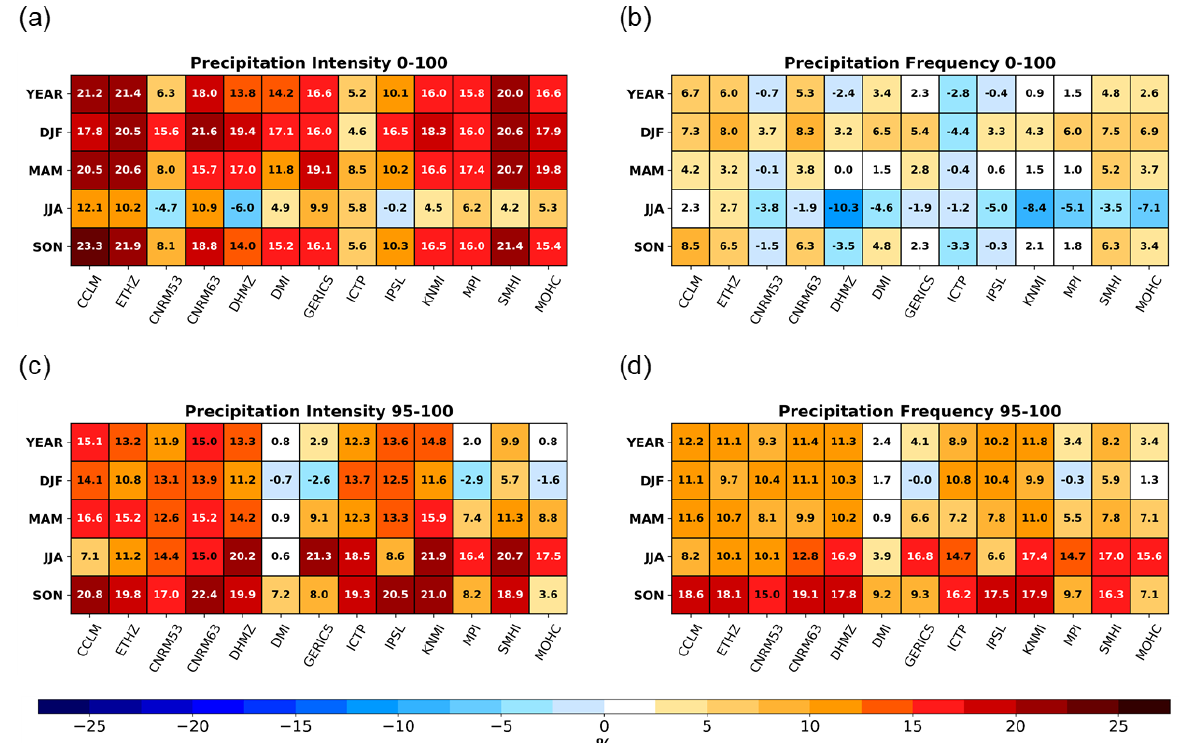
Figure 2. Yearly and seasonal distribution added values (DAVs) of the Iberian Peninsula between the RCMs and the ERA-Interim reanalysis for the 1989–2008 period taken from the hindcast EURO-CORDEX simulations, with the IGD regular dataset as a reference for (a) daily precipitation intensity considering the whole PDF shown in the left panels of Fig. S1, (b) daily precipitation frequency considering the whole PDF shown in the right panels of Fig. S1, (c) daily precipitation intensity extremes only considering the values above the observational 95th percentile shown in Fig. S1 on the left side, and (d) daily precipitation frequency extremes only considering the values above the observational 95th percentile shown on the right side of Fig. S1. All RCM data were previously interpolated to 0.1 ◦ regular resolution from the observations, while the observations were interpolated into the ERA-Interim